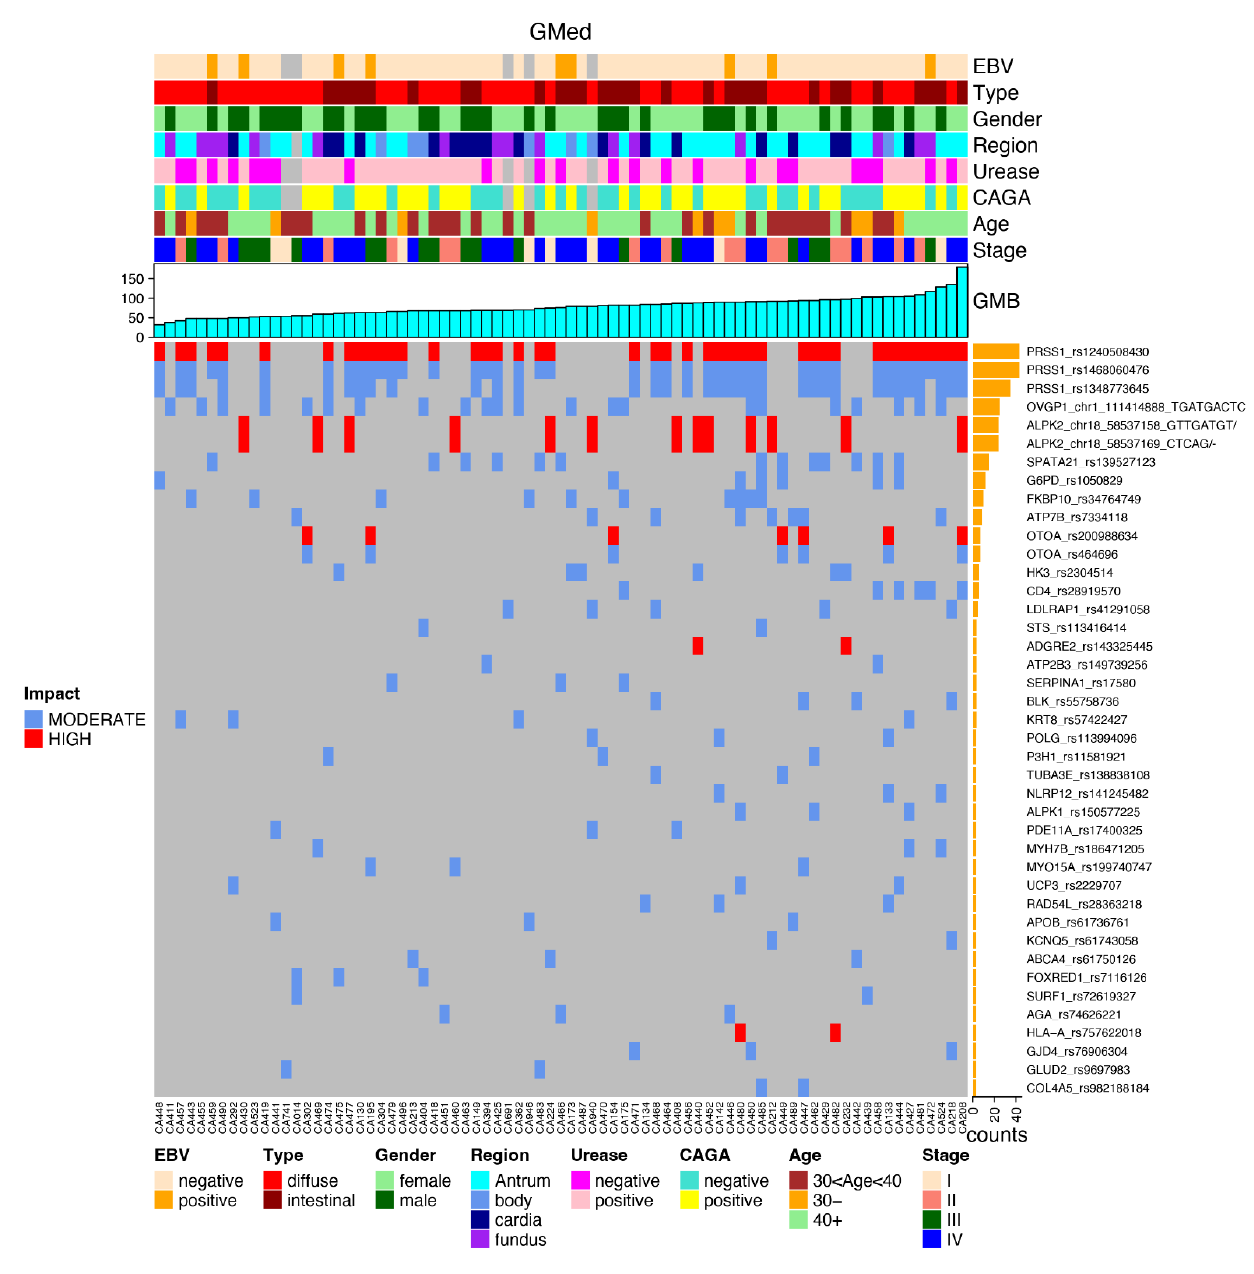
Figure 6. Correlation of most prevalent variants in the GMed gene’s subset among young patients with gastric cancer and their distribution according to clinical features (EBV status, histological type, gender, region of the stomach, urease status, CAGA status, age group and stage), GMB and mutation impact (moderate or high).